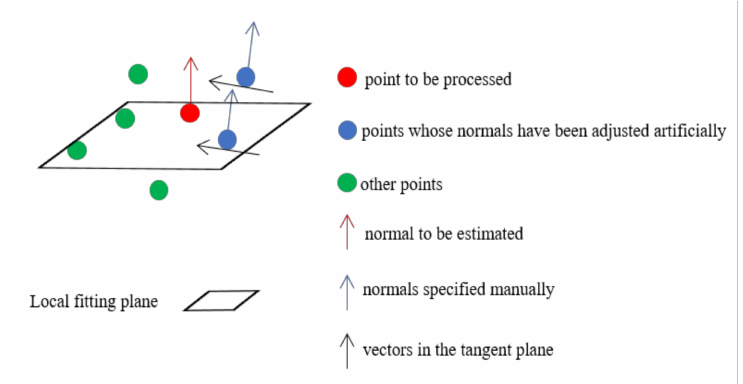
Figure 2. Considering the points whose normals have been adjusted